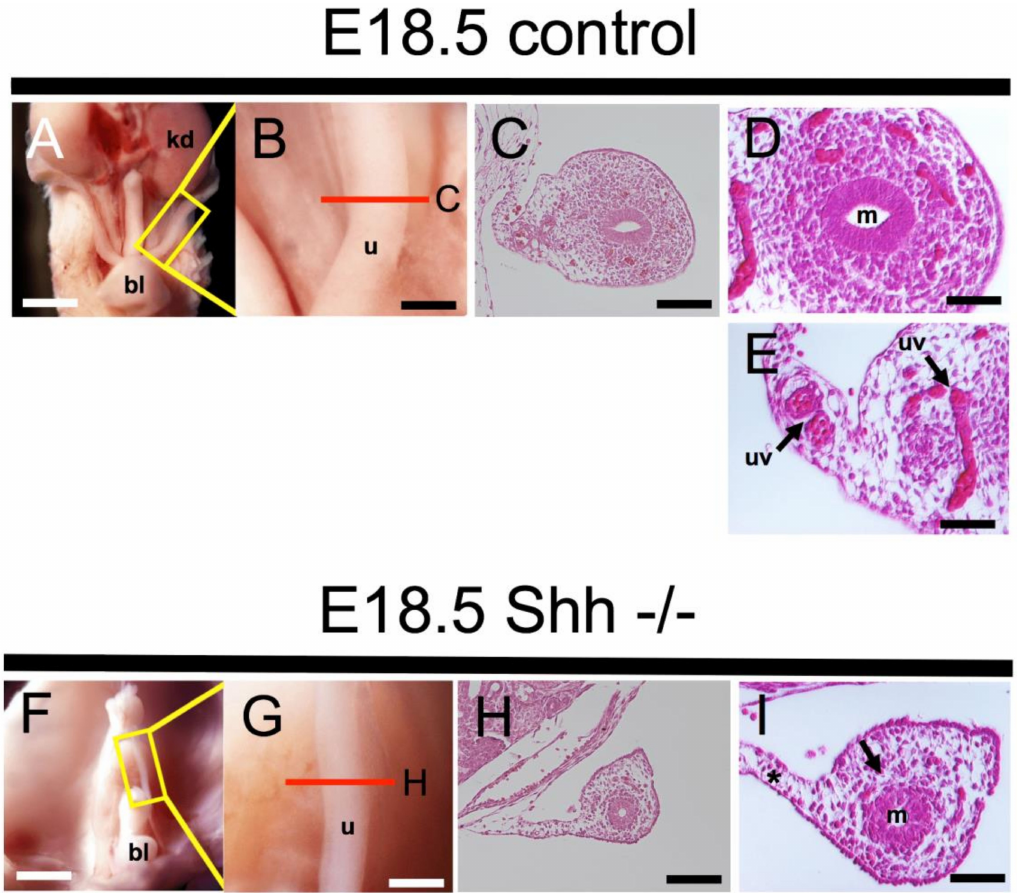
Figure 2. Developmental defects of FRT in Shh KO mice. ( A , B , F , G ) Macroscopic frontal views of E18.5 control and Shh mutant urogenital organs. Mutants show severe developmental anomalies in the bladder, kidney and uterus ( F , G ). ( C – E , H , I ) Section images of HE-stained control and mutant uterus. In ( I ), mutants indicate small amounts of mesenchymal tissue surrounding the Mullerian duct (black arrow) and the lack of uterine artery in the uterus (asterisk). Red lines in ( B ) and ( G ) indicate sites of transverse sections in ( C , H ). ( D , E , I ) Higher magnification of control and mutant uterus. These results were observed in several individuals ( n = 3). bl, bladder; kd, kidney; u, uterus; uv, uterine vessel; m, Mullerian duct. Scale bars indicate 500 µ m ( A , F ), 200 µ m ( B , G ), 100 µ m ( C , H ), and 50 µ m ( D , E , I